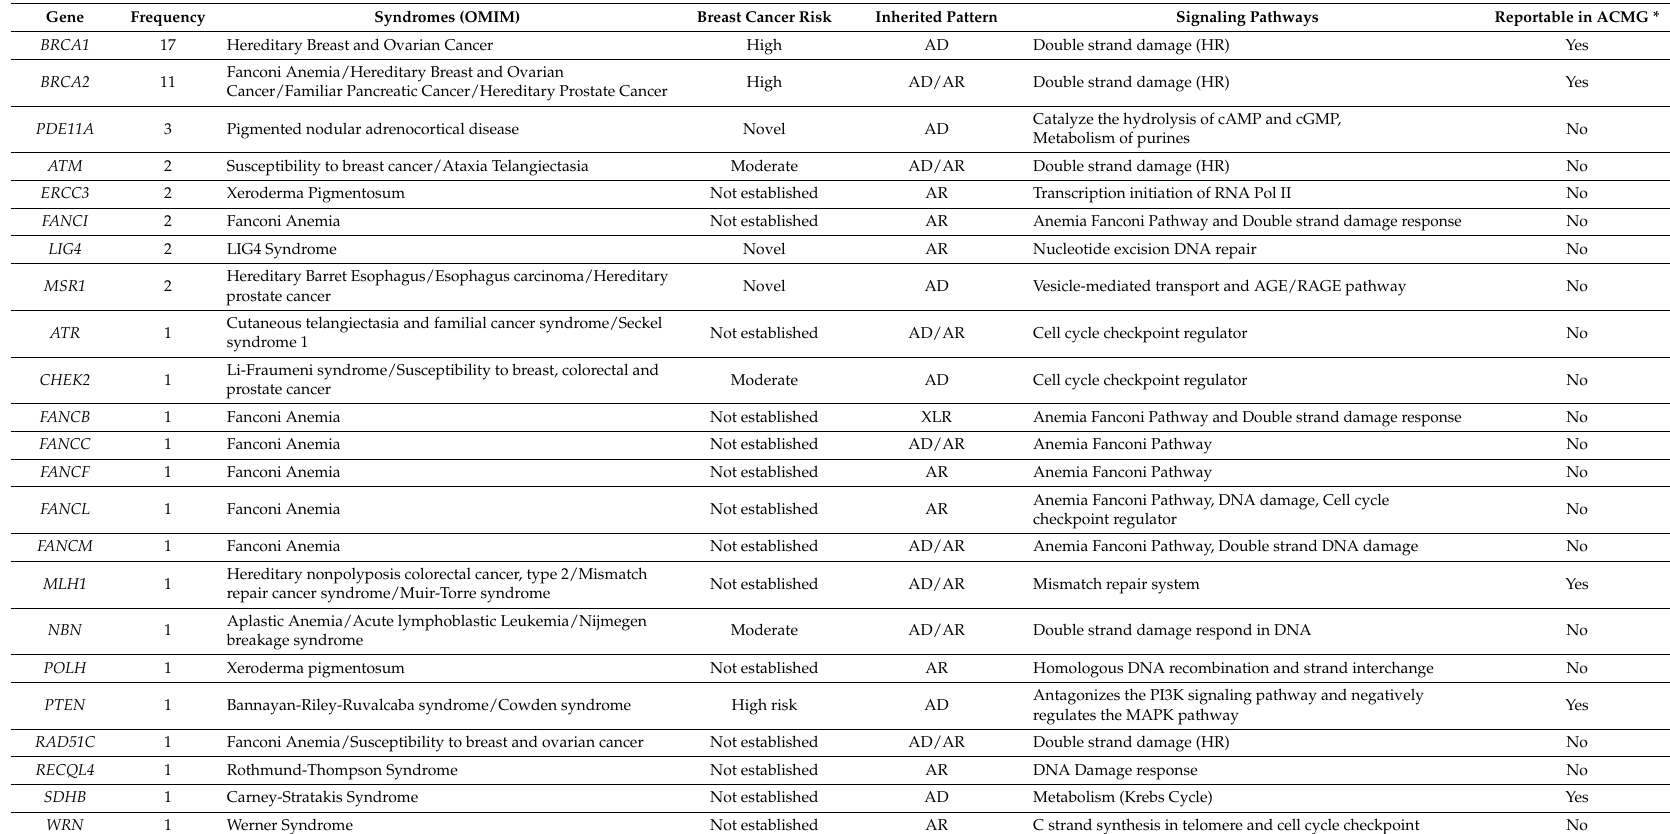
Table 3. Syndromes associated with the pathogenic variants